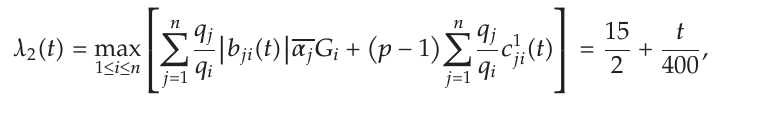
(cid:5) t (cid:6)(cid:6) ,E (cid:5) y 4 (cid:5) t (cid:6)(cid:6) of system (cid:5) 4.1 (cid:6) 2 1